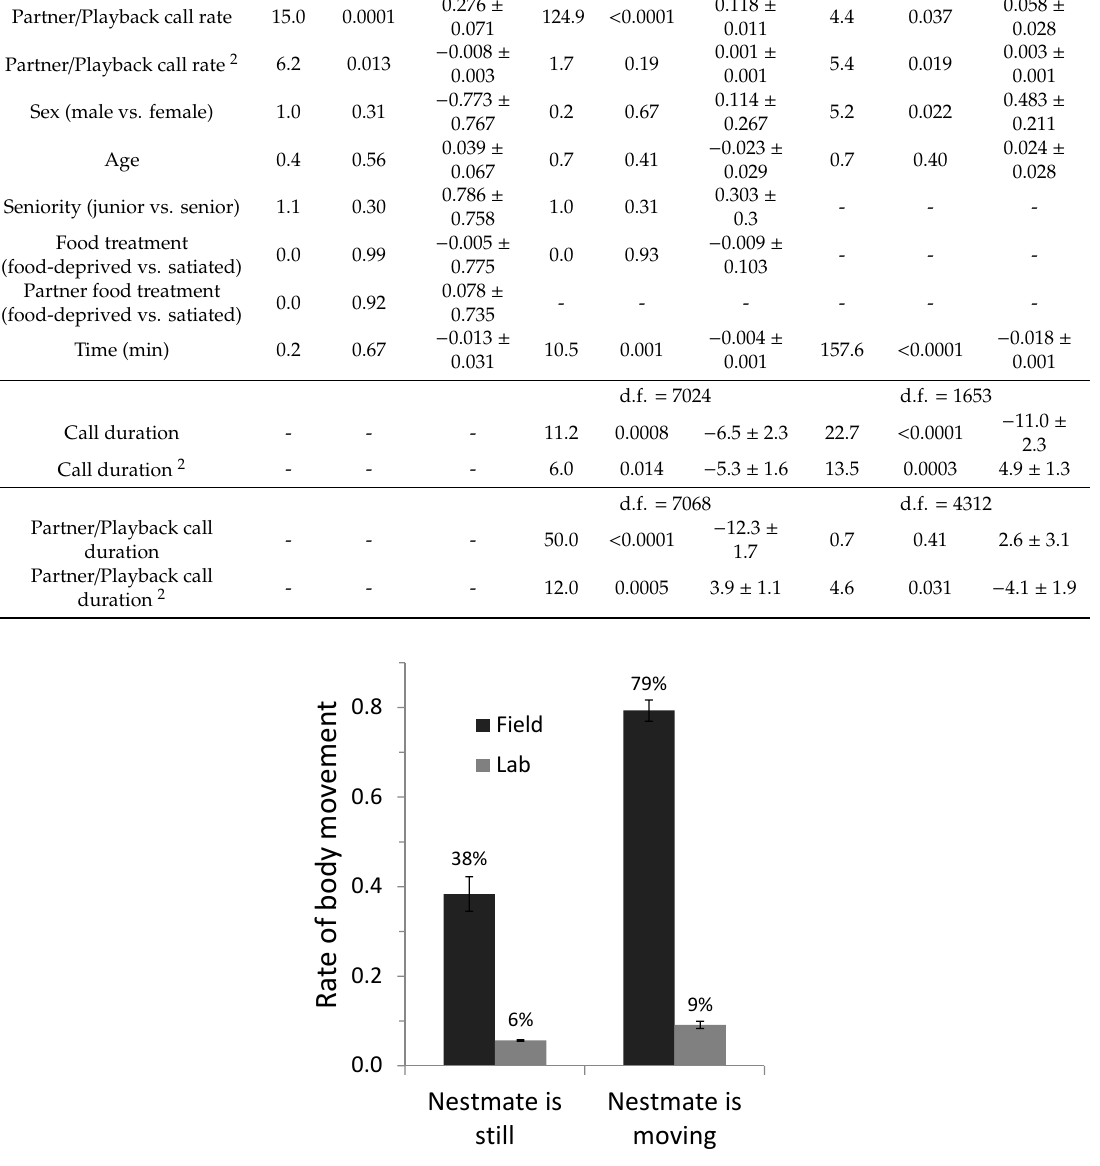
Figure 2. Body movements (occurrence in each minute) of focal barn owl nestlings according to whether their partner was still or performing a body movement, in pairs of nestlings in their natural nest (black bars, experiment 1) or in the laboratory (grey bars, experiment 2). Bars represent standard errors.